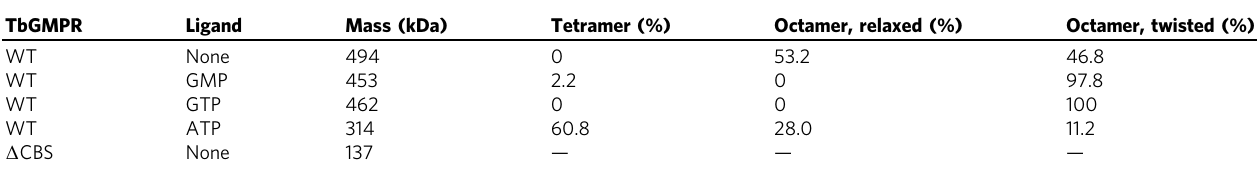
Table 3 Analysis of oligomeric state of TbGMPR WT and TbGMPR Δ